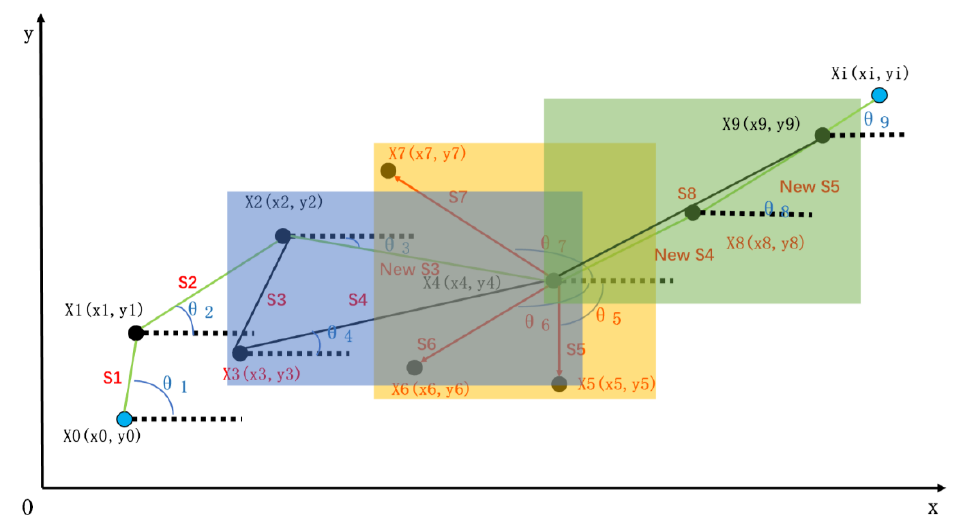
Figure 7. ResNet50 structure.